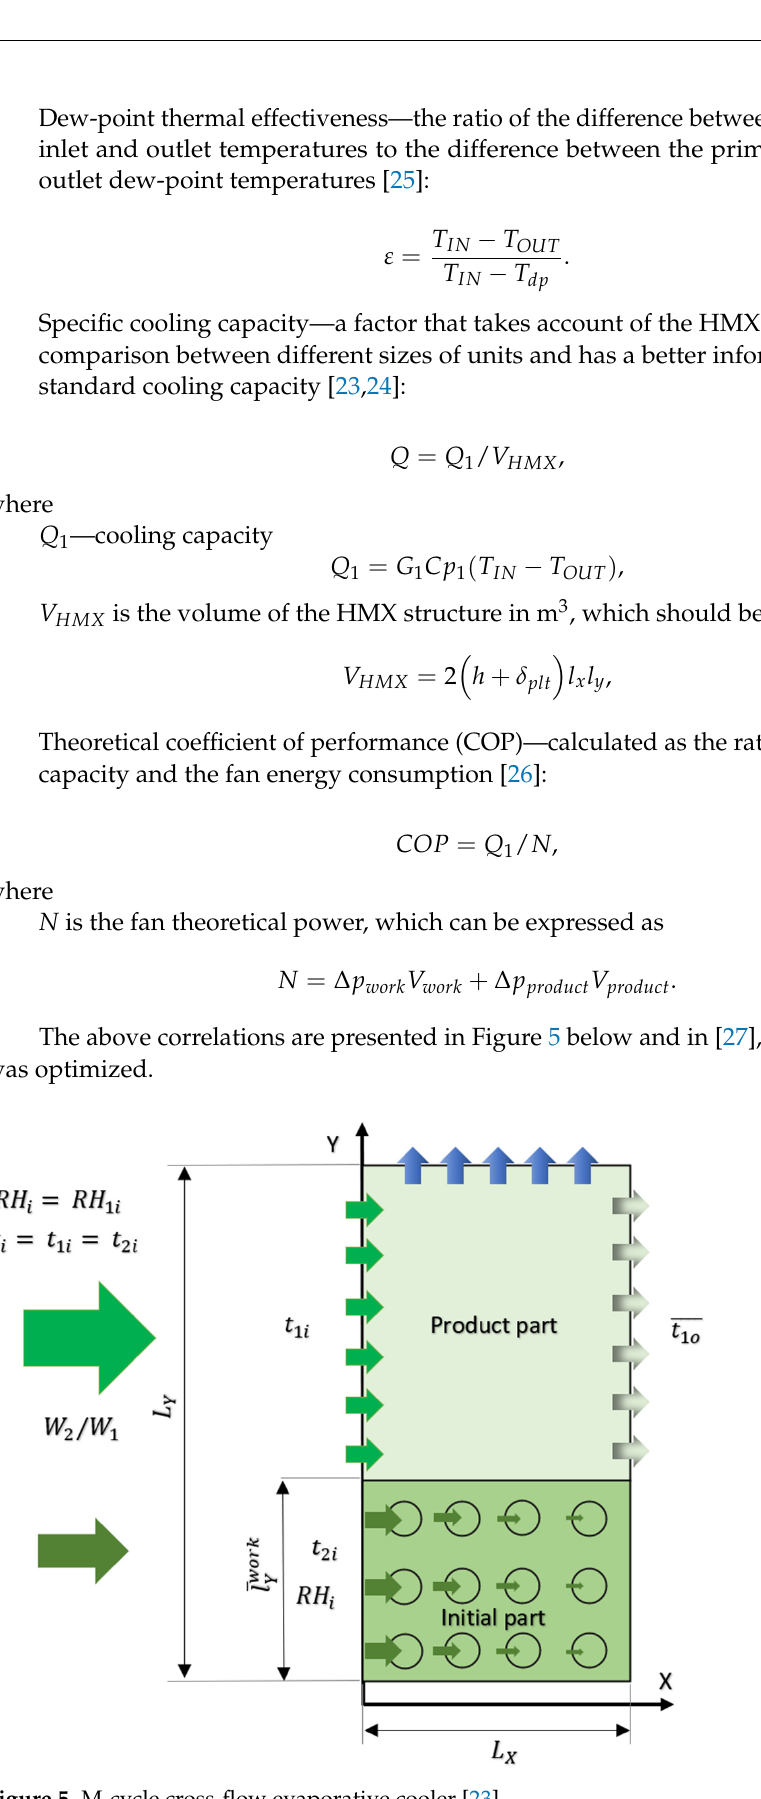
Figure 5. M-cycle cross-flow evaporative cooler [23].